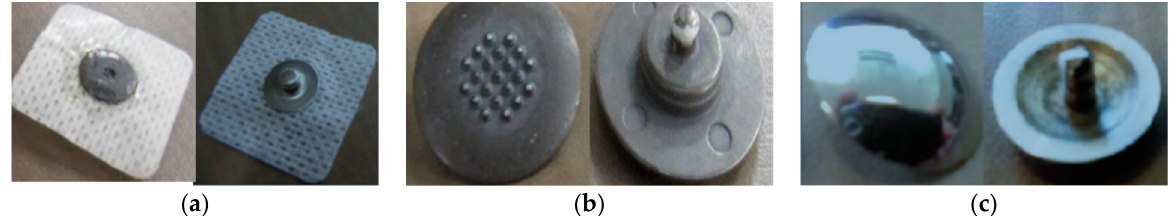
Figure 3. ECG electrodes with skin side (left) and snap side (right): ( a ) Ag/AgCl; ( b ) orbital with 150 µm pins; and ( c ) stainless steel electrode. Adopted from [47].